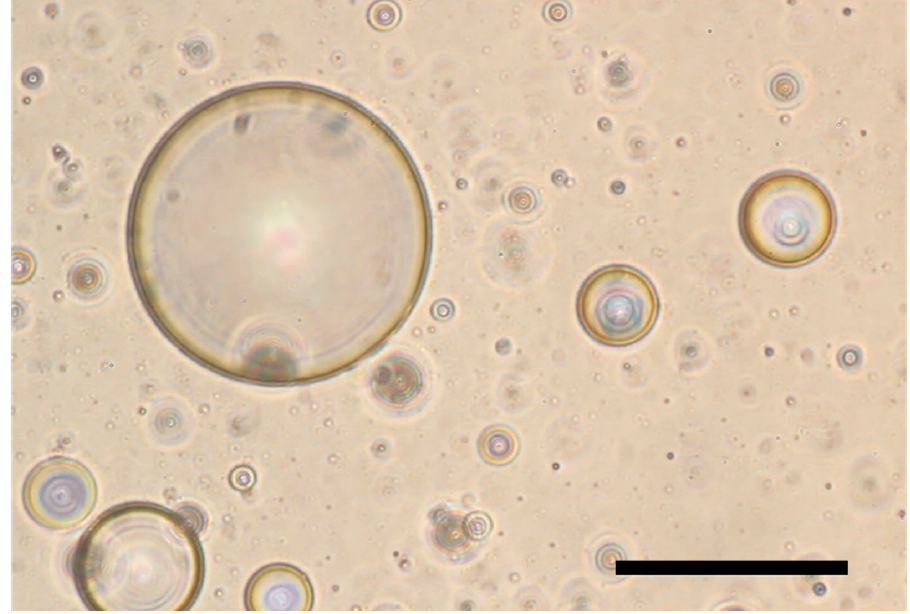
Figure 9. Micrograph of the produced gelatin microspheres using emulsification method. Scale bar, 50 µ m.